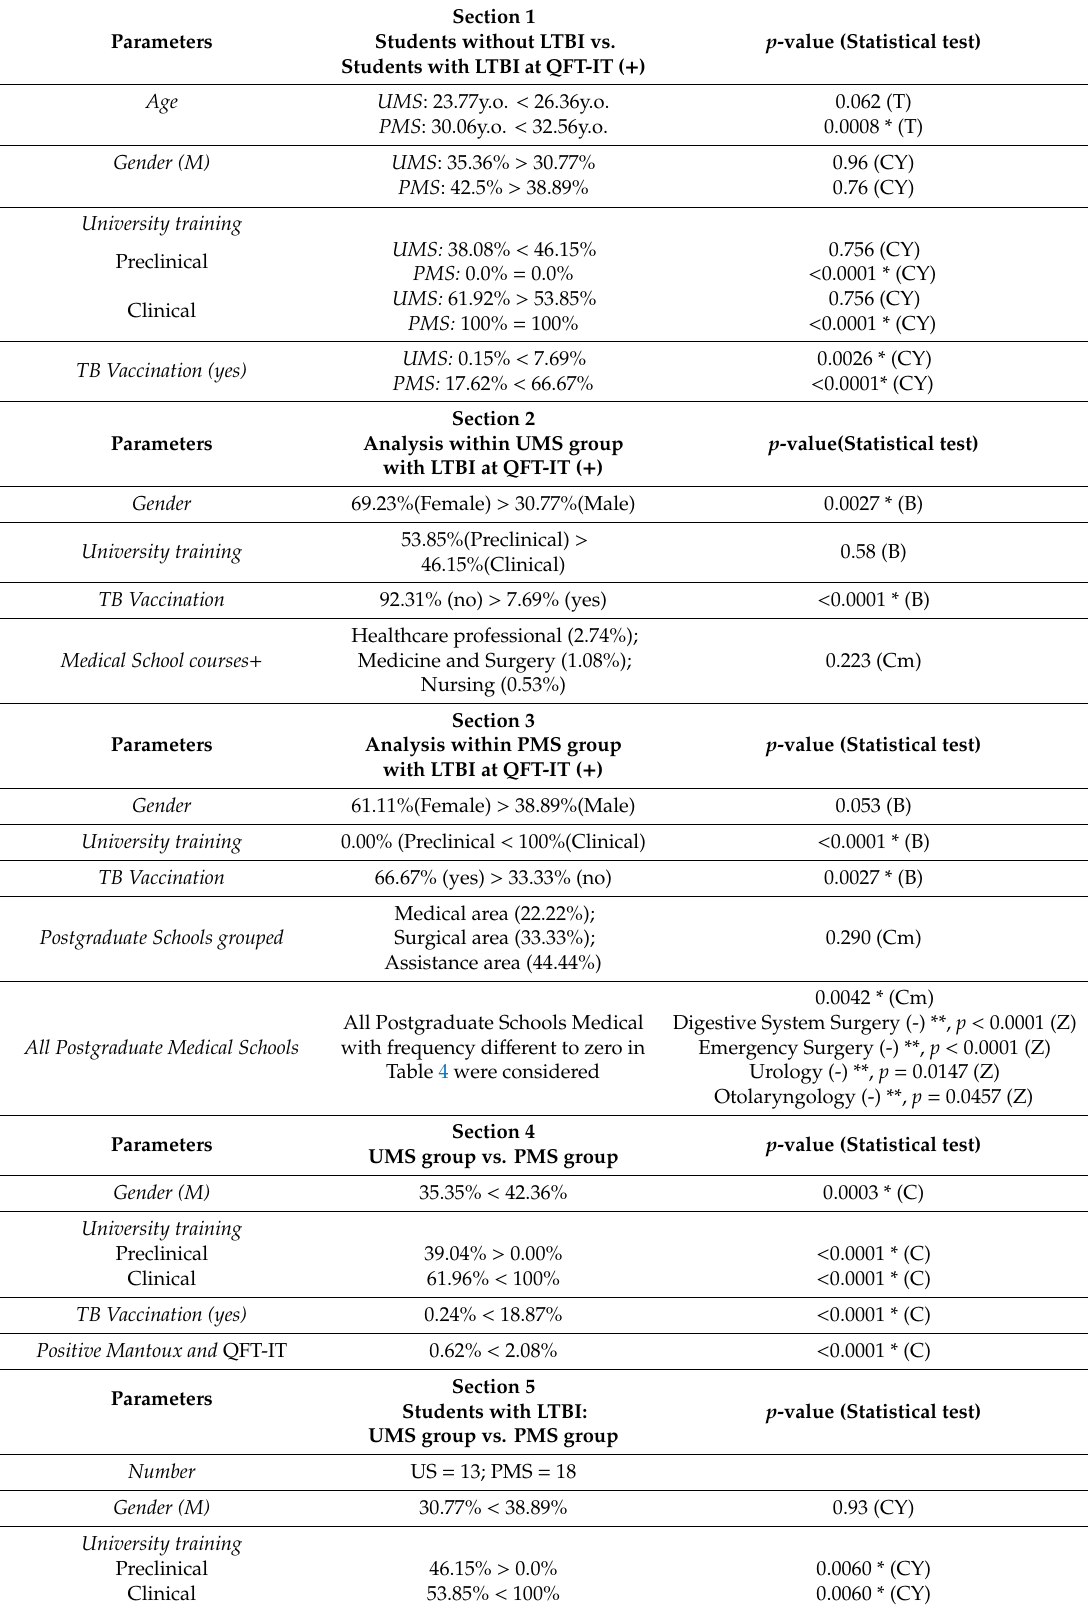
Table 4. Statistical